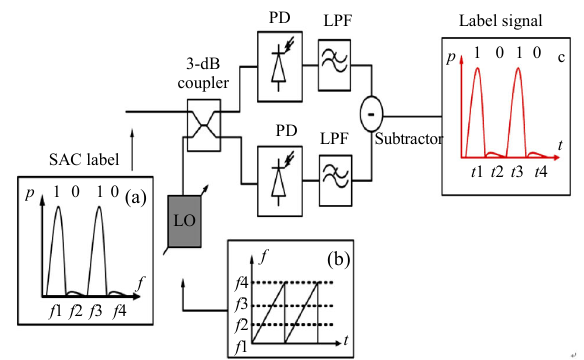
Fig. 2 Principle of frequency-swept coherent detection of SAC label: (a) input SAC label in the wavelength domain, (b) frequency-swept LO, and (c) output SAC label in the time